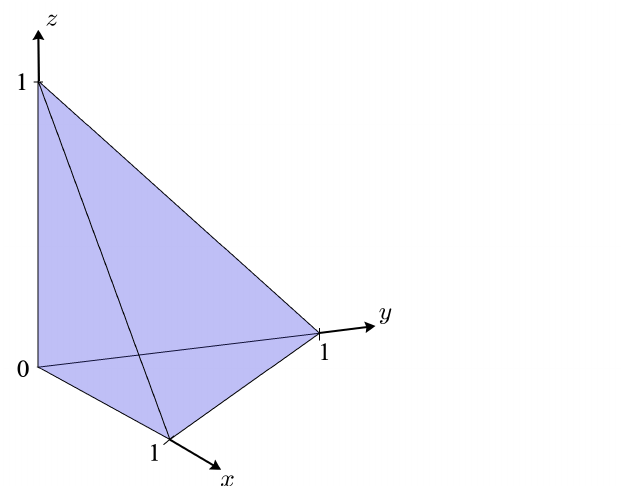
Figure 1. The coordinated subspace for 3-player GDD game. Each point represents a set of demands. The triangle with vertices (1 0 0), (0 1 0), and (0 0 1) is a 2-simplex. Every point on the simplex has a demand total of $1. Coordinated demands lie on or beneath the